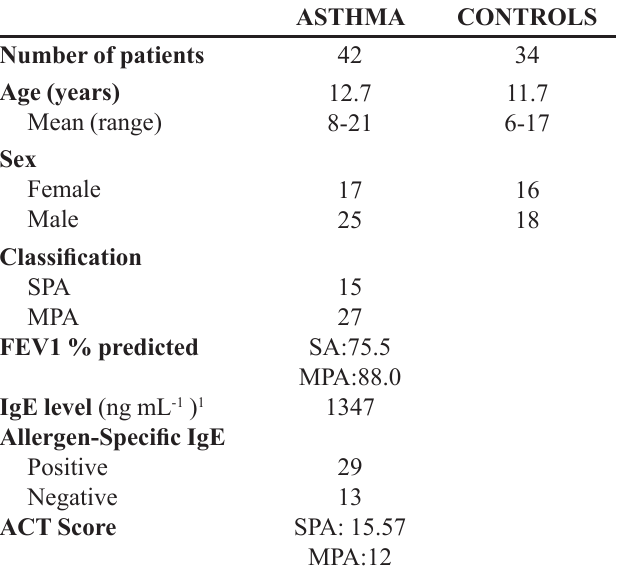
TABLE I - Demographic, clinical and laboratory data of asthma